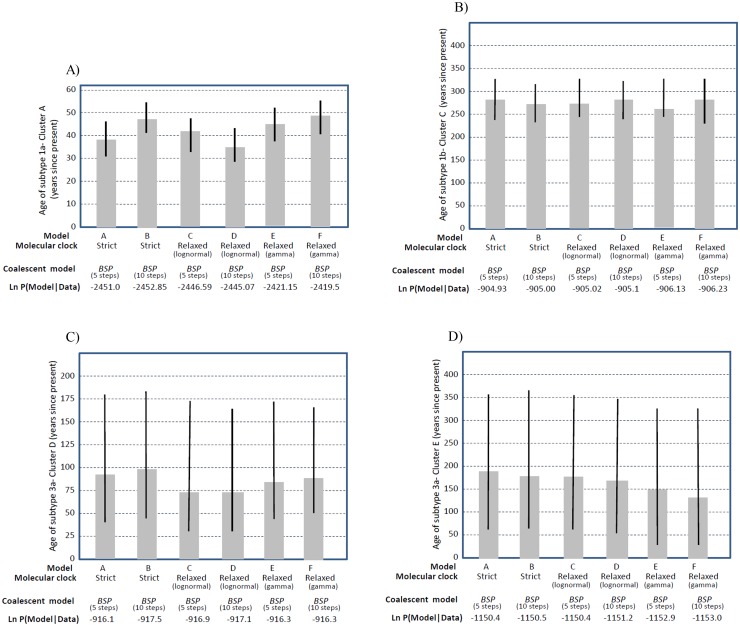
Estimated dates of HCV subtypes origin, as obtained under model combinations A to F.(A) Subtype 1a, cluster A. (B) subtype 1b, cluster B. (C) subtype 3a, cluster D. (D) subtype 3a, cluster E (see text for further details). The bars show the 95% credible intervals of each estimate.